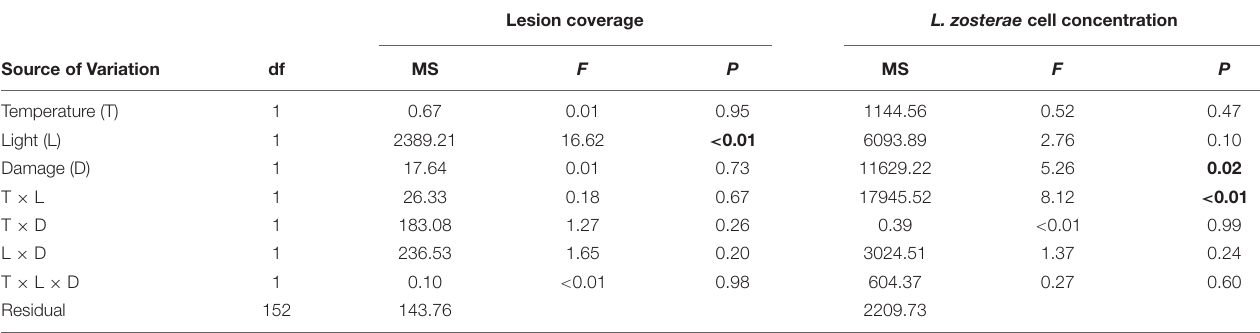
TABLE 2 | Analysis of variance of lesion coverage (%) and Labyrinthula zosterae cell concentration (cells mg − 1 Zostera marina dry weight) in Z. marina grown under different levels and combinations of temperature (ambient and increased), light (reduced and ambient), and tissue damage (damaged and undamaged). Lesion coverage L. zosterae cell